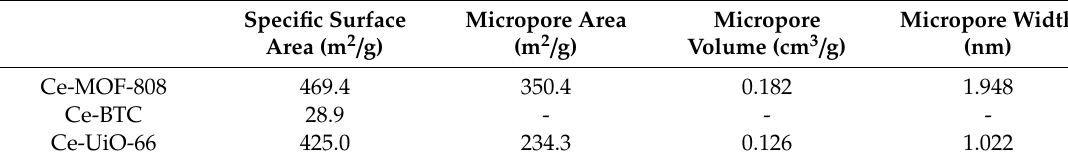
Table 1. The surface properties of Ce-MOFs.